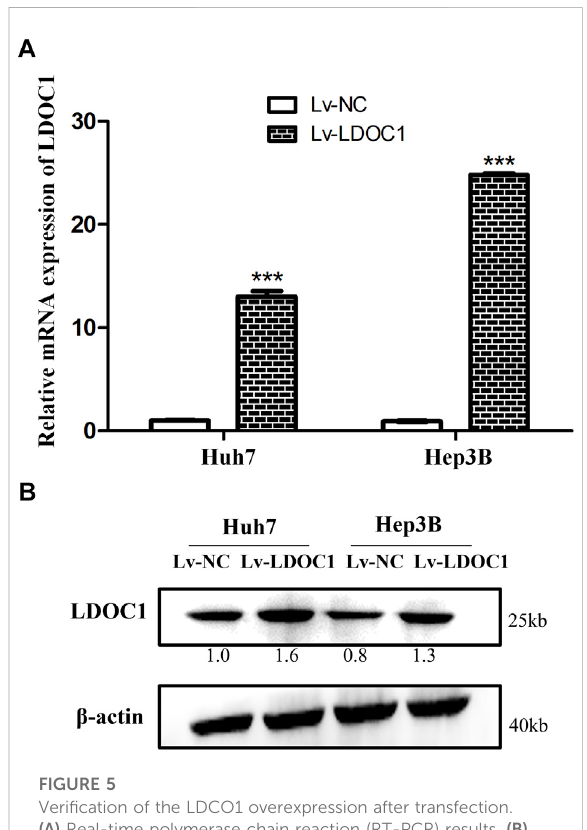
FIGURE 5 Veri fi cation of the LDCO1 overexpression after